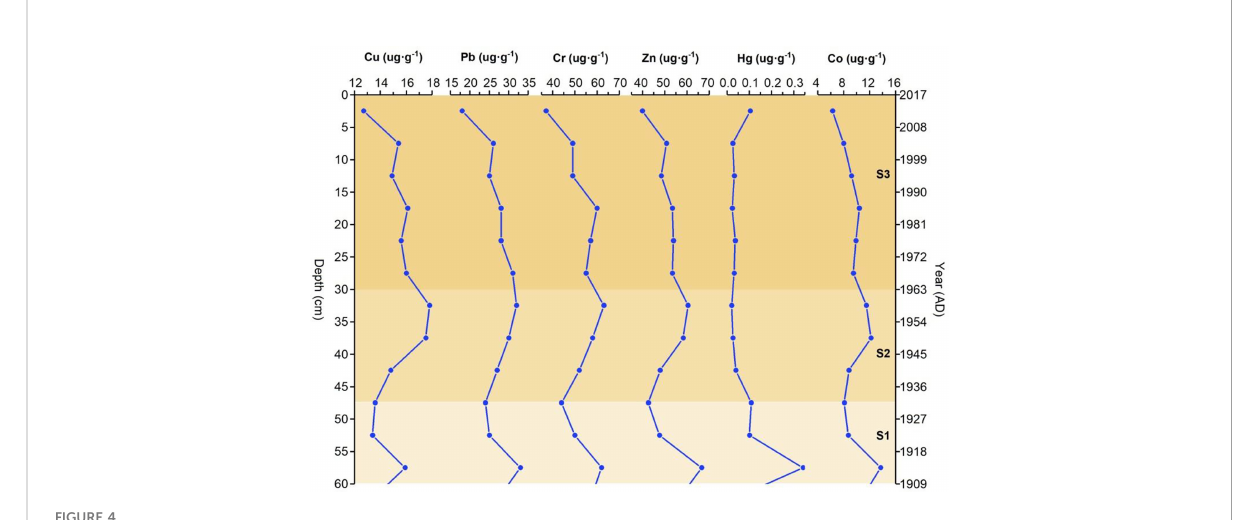
FIGURE 4 Heavy metal deposition sequence of